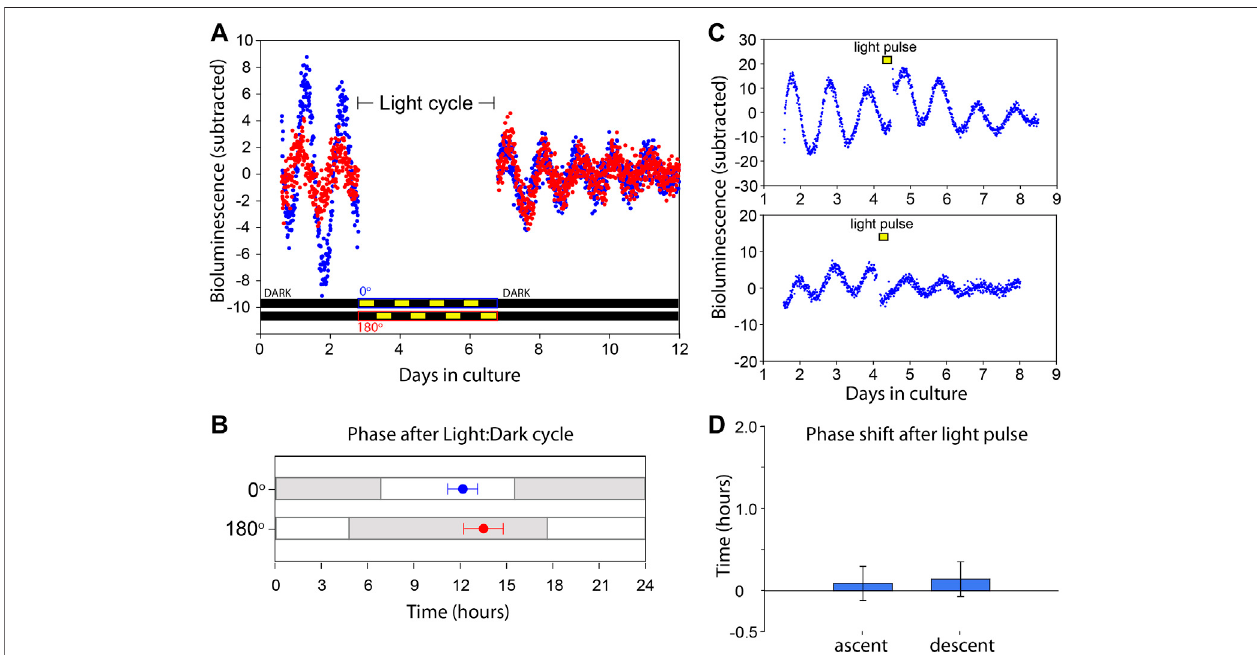
FIGURE3| VMPOcircadianclockisnotdirectlyentrainedbylight. (A) Bioluminescencetracesof Per2 Luciferase fromtwoindependentorganotypiccultures(redand blue) of VMPO. The cultures are removed from PMT measurement and exposed to Light:Dark cycles from days 3 to 7. Light paradigms are indicated below for blue (0 ° ) and red (180 ° ) cultures. Light consisted of 415 nm, 2 × 10 14 photons cm − 2 s − 1 . (B) Phase of luminescence traces in constant darkness after exposure to oppositely phased Light:Dark cycles for 4 days. Points are average (±SEM) phases of fi rst peak after return to PMT measurement with previous Light:Dark cycles indicated with gray and white shading. n = 8. (C) Bioluminescence traces of VMPO from Per2 Luciferase mice given 90 min light pulses where indicated with a yellow box (415 nm, 2×10 14 photonscm − 2 s − 1 ). (D) Averagephasechange(comparingphaseofrhythmindays5 – 7tophaseindays1 – 4)afteralightpulseadministrationoccurringeitherin the early ascending phase of the luminescence rhythm (left, and upper panel of (C) or early descending phase (right, and lower panel of (C) . Shown are mean ± SEM. n = 5 each.